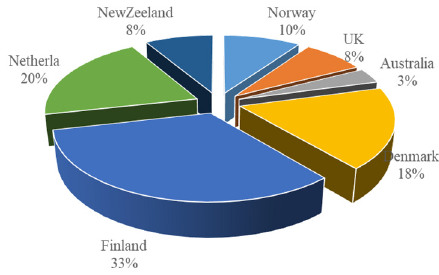
Figure 9. Reduction in CO 2 in tonnes per country and year with ENTEC (adapted with permission from Ref. [34]. 2021. Díaz-Ruiz-Navamuel, E.).